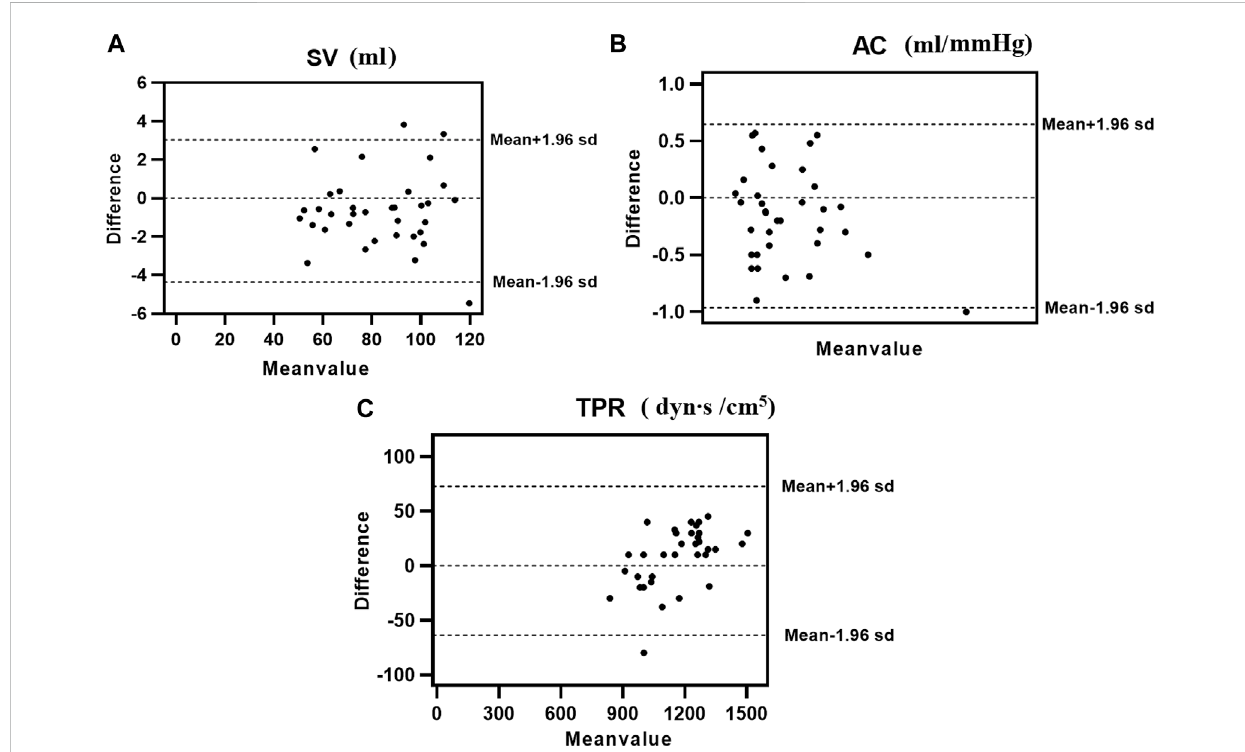
FIGURE 4 Consistency analysis between calculation and clinical measurements value of (A) SV, (B) AC, and (C) TPR; The relationship between the average (horizontal axis) and the difference (vertical axis) is illustrated using scatter